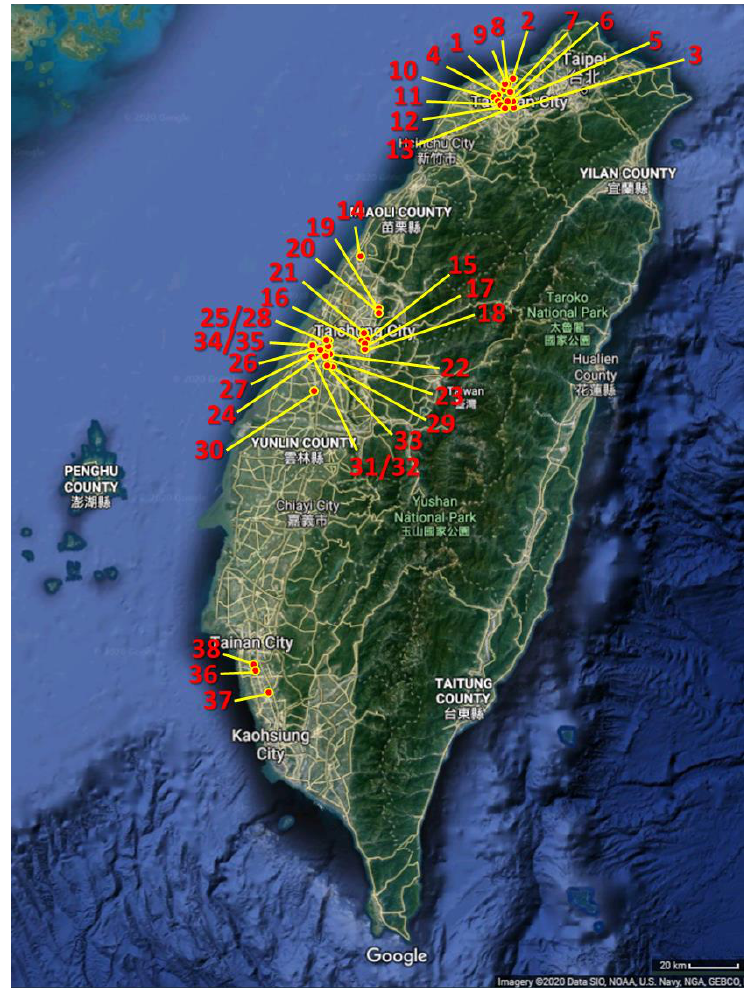
Figure 3. Representative automatic monitoring networks for irrigation water quality monitoring at Taoyuan, Taichung, Changhua, and Kaohsiung. The satellite map is from Google Maps (Map data © 2020 Google; https: // www.google.com / maps / place / Taiwan). The maps were edited with